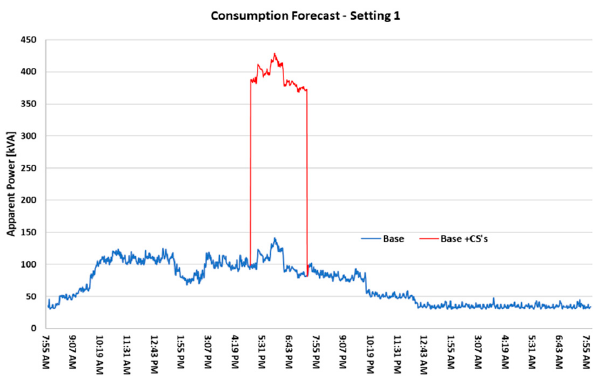
Figure 6. Consumption Forecast—Setting 1.